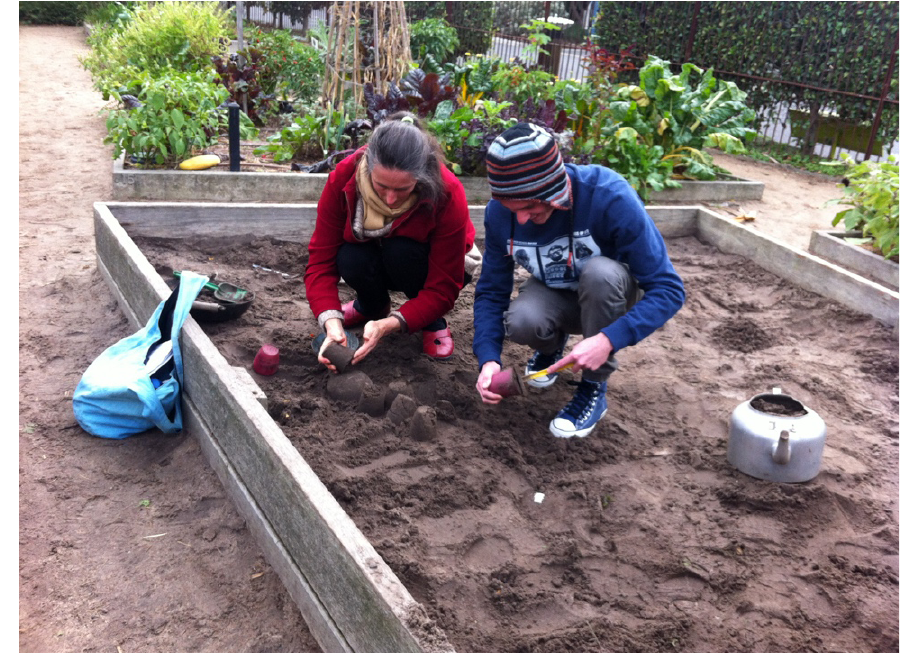
Figure 1. Students learning how to play at the Ian Potter Foundation’s Children’s Garden.